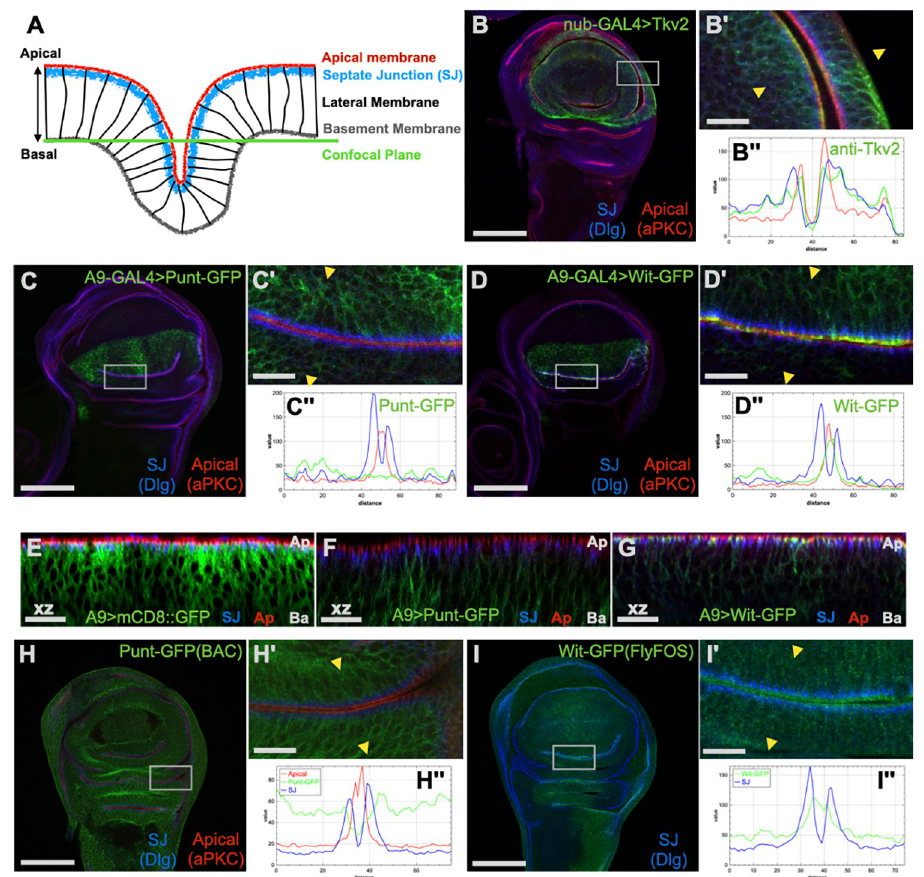
Fig 1. Punt exhibits basolateral membrane localization in the wing disc. (A) Schematic showing apical–basal features of the wing disc epithelium. Stereotypical folds bring 2 surfaces near each other with apical sides in apposition. Confocal images through the folds thus reveal the apical–basal polarity axis of the columnar epithelial cells. (B) Tkv expressed with nub -GAL4 was detected at the SJ (marked with FasIII or Dlg), as well as basal, lateral, and apical membranes (marked by aPKC stripe). Tkv2 was visualized by IF using an antibody specific to this isoform (B). See S1 Fig for additional Tkv localization tests. (C–G) GFP fluorescence signal conveys the membrane distribution of Type II receptors relative to junctions. Punt-GFP was largely excluded from the SJ (Dlg) and apical (aPKC) regions but detected at basolateral surfaces (C). Wit-GFP is enriched at the apical membrane but also detected basolaterally (D). (E–F) Apicobasal distribution of GFP-tagged proteins shown by xz projections of confocal z-sections. Apical (Ap) and Basal (Ba) sides are labeled. mCD8::GFP driven by A9-Gal4 was distributed through the columnar epithelial cells, with clear overlap at the SJ (E). Punt-GFP was excluded from the SJ and apical areas, displaying basolateral restriction (F), whereas Wit-GFP exhibited broad membrane localization with prominent overlap with the SJ and apical regions (G). (H, I) Endogenous-level tagged constructs confirm differential localization of Punt and Wit. Punt-GFP (H) or Wit- GFP (I) were detected by anti-GFP IF and analyzed as for Panels C and D; apical localization of Wit-GFP is inferred by staining apical to the SJ. Single prime ( 0 ) images are magnified views where 2 portions of the epithelium lean toward each other. Double prime ( 00 ) images are intensity profiles perpendicular to the line demarcated by the junction staining (yellow arrowheads in single prime panels; see S1 Fig for schematic of profile markers). Scale bars: 100 μ m for B, C, D, H, I; 15 μ m for B 0 , C 0 , D 0 , E, F, G, H 0 , I 0 . IF, immunofluorescence; SJ, septate junction. corresponding to the mammalian “LTA” targeting motif [20] did not disrupt BLT (Fig 2G). Indeed, removal of nearly the entire cytoplasmic portion of Punt produced a protein with basolateral localization (Fig 2I). This behavior was recapitulated in a truncation series in the context of chimeric receptors containing variable lengths of the Punt cytoplasmic domain (S2 Fig). These data reveal that BLT of TGF- β pathway receptors in epithelia is phenomenologi- cally conserved from flies to mammals, but that different portions of the protein and amino acid sequences direct the sorting of fly Punt and mammalian T β RII.